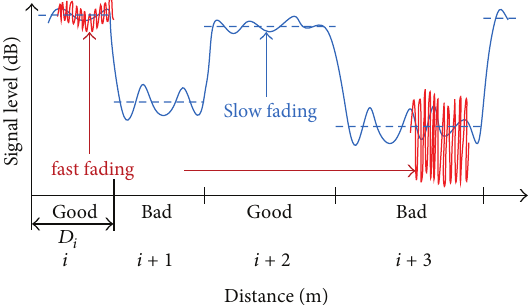
Figure 7: Features of the proposed two-state LMS model, where 𝑖 is the state interval index. Each state has a possibly different interval duration 𝐷 𝑖 and a new Loo triplet Ω 𝑖 consisting of 𝑀 𝐴,𝑖 , Σ 𝐴,𝑖 , and 𝑀𝑃 𝑖 drawn from random